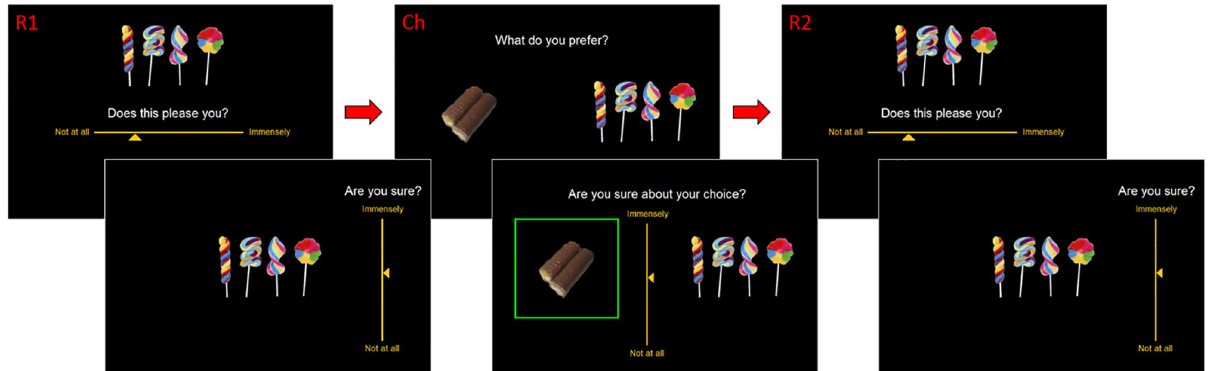
Fig 2. Behavioural paradigm (RCR group). The experiment was divided into three sessions. First, participants were asked to rate each item’s value and report their level of uncertainty regarding this value rating. In the main text, we refer to these as "pre-choice value" and "pre-choice value certainty", respectively. Second, participants are asked to chose between pair of items and report their confidence about this decision. In the main text, we refer to the latter as "choice confidence". The third session is identical to the first one, and we refer to the corresponding measures as "post-choice value" and "post-choice value